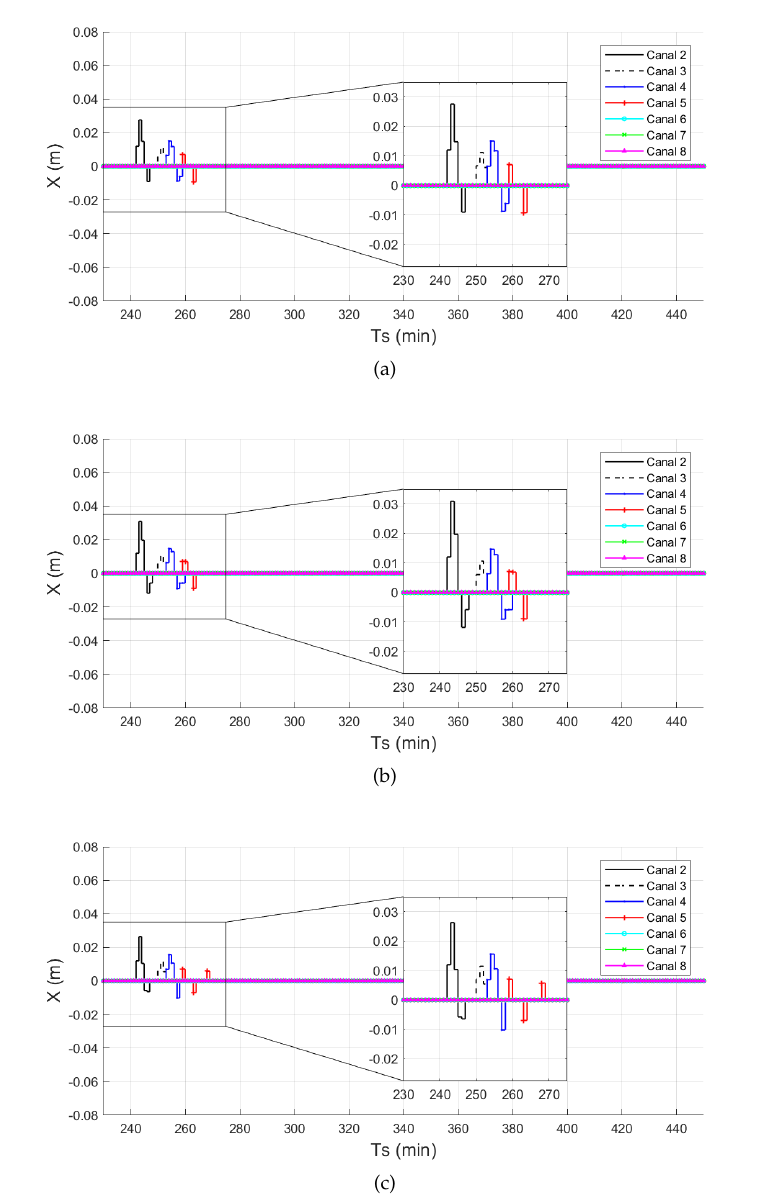
Figure 2. Simulation results for step change of 0.2 m 3 /s in the non-lineal canal model for the LMI methods (described in Section 2.2.2): ( a ) Q tuning approach 1 of LMI method; ( b ) Q tuning approach 2 of LMI method; ( c ) Q tuning approach 3 of LMI